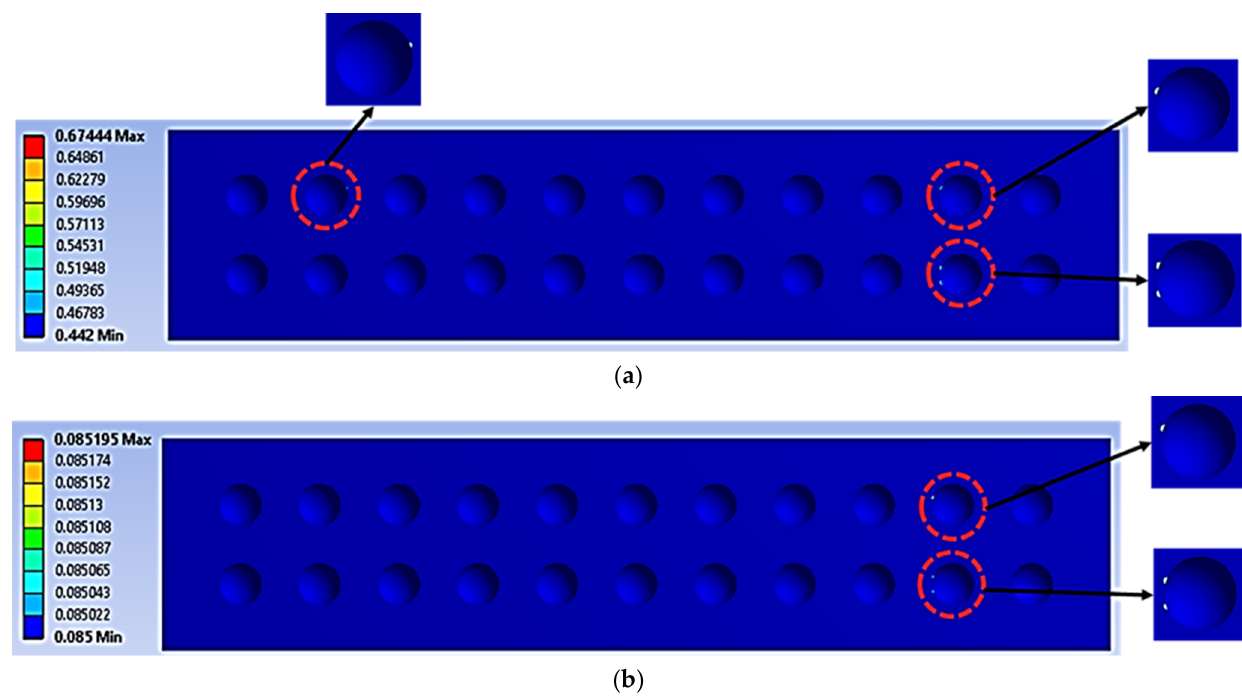
Figure 12. The life cycle (denoted as N f ), at the core panel of a simulated panel under cyclic loading conditions (units in cycle): ( a ) 70%, ( b ) 50%.